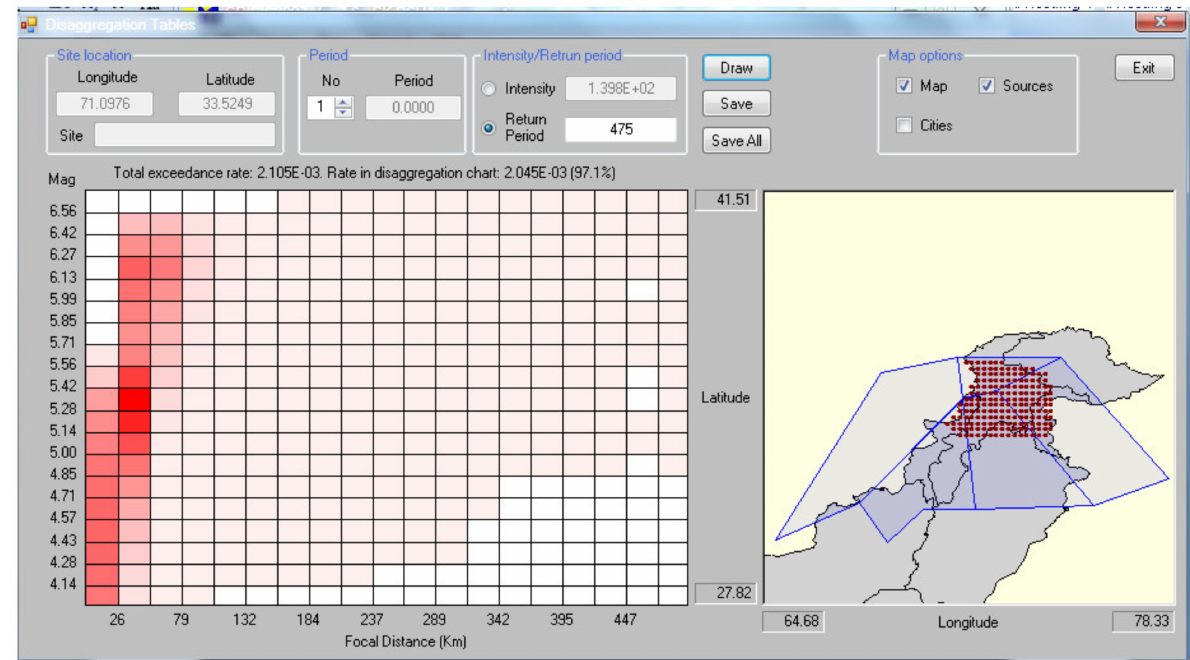
Figure 13. De-aggregation results for BA08 attenuation relation.